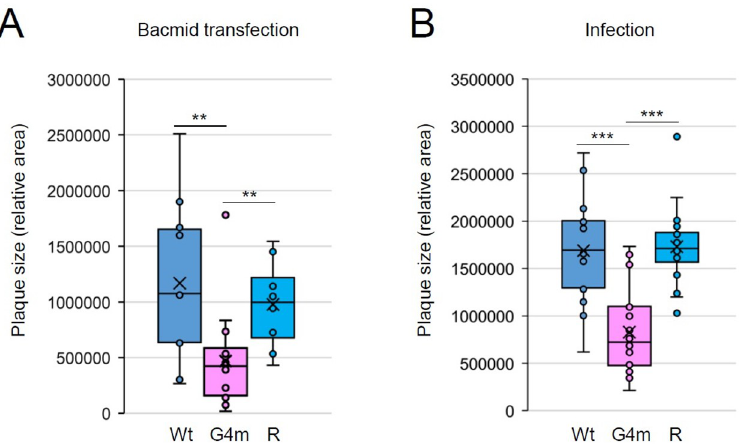
Fig 9. Comparison of plaque sizes of ORF14 recombinant viruses. (A) MeWo cells in six-well plates were transfected with the VZV bacmids (1 μ g) containing the ORF14-HA gene [wild-type, G4m, or revertant (R)]. At 8 days after transfection, images of GFP+ plaques were taken. A similar plaque size reduction pattern was found with the G4m virus in two independent experiments. Since the efficiency of plaque generation in bacmid-transfected cell is low, we combined all plaques (n = 11 for Wt, n = 17 for G4m, and n = 8 for G4m-R) in two experiments to make the graph. Plaque area size was measured with ImageJ and shown as a box and whisker graph. Box plots show the first and third quartiles as a box. Horizontal lines are samples median. X corresponds to the mean. Whiskers correspond to 1.5 times the inter-quartile distance (IQR) from the difference between first and third quartiles. Images showing plaques are shown in S7A Fig. (B) MeWo cells in six-well plates were infected with cell-associated recombinant viruses. At 5 days after infection, cells were stained with crystal violet and plaque size was measured (n = 20) and shown as a graph as in (A). The experiments were performed more than three times and showed similar results. The data from a representative experiment are shown. Plaques images are shown in S7B Fig.